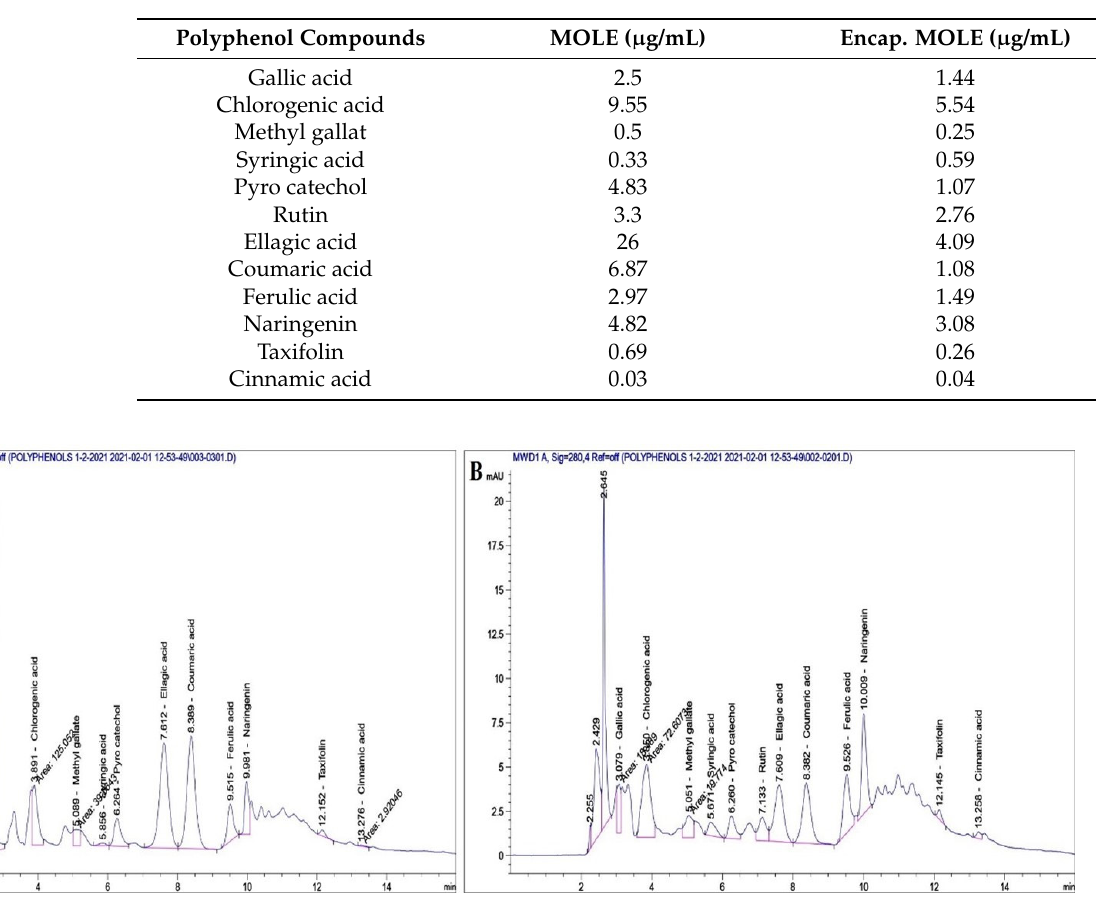
Table 2. Identification and concentration of polyphenolic compounds in MOLE and Encap. MOLE.